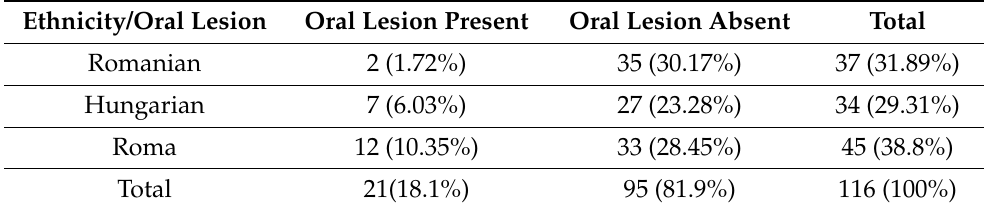
Table 3. The distribution of oral lesions according to ethnicity.